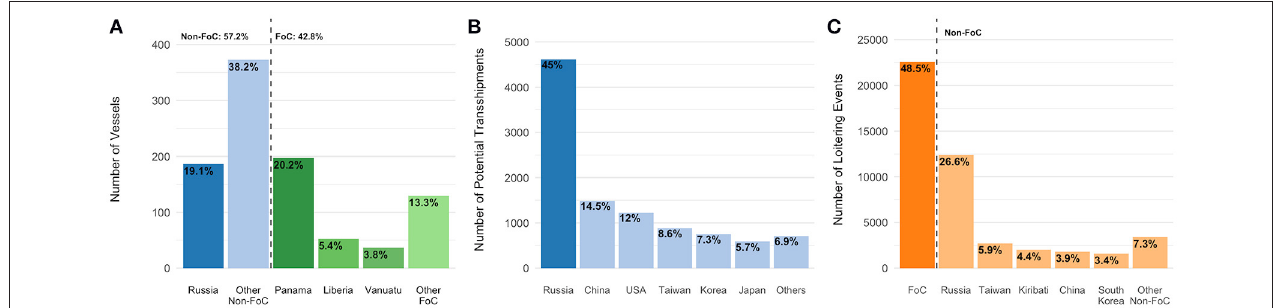
FIGURE 1 | Flag state patterns. (A) top flag states transshipment vessels, identifying nearly 43% flying Flags of Convenience (FoC), (B) top flag states of fishing vessels involved in encounters, illustrating that nearly 45% of these events involved Russian fishing vessels, (C) Top flag states of cargo vessels involved in loitering events, illustrating the overrepresentation of Russian vessels ( ∼ 19% of the transshipment vessels involved in ∼ 27% of these events) and the prevalence of vessels flying FoCs.